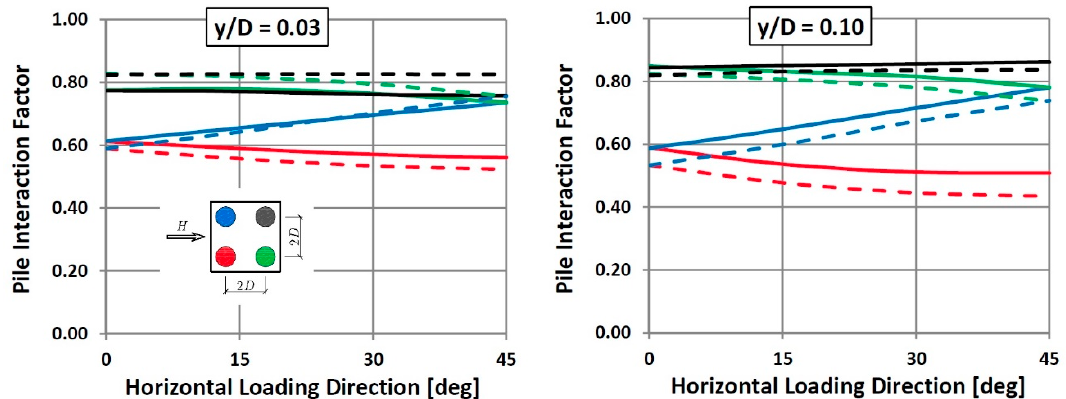
Figure 10. Pile interaction factors for square 2 × 2 pile group ( s x = 2 D , s y = 2 D ). Different colors denote piles inside the pile group. Full lines—loose sand; dashed lines—dense sand.